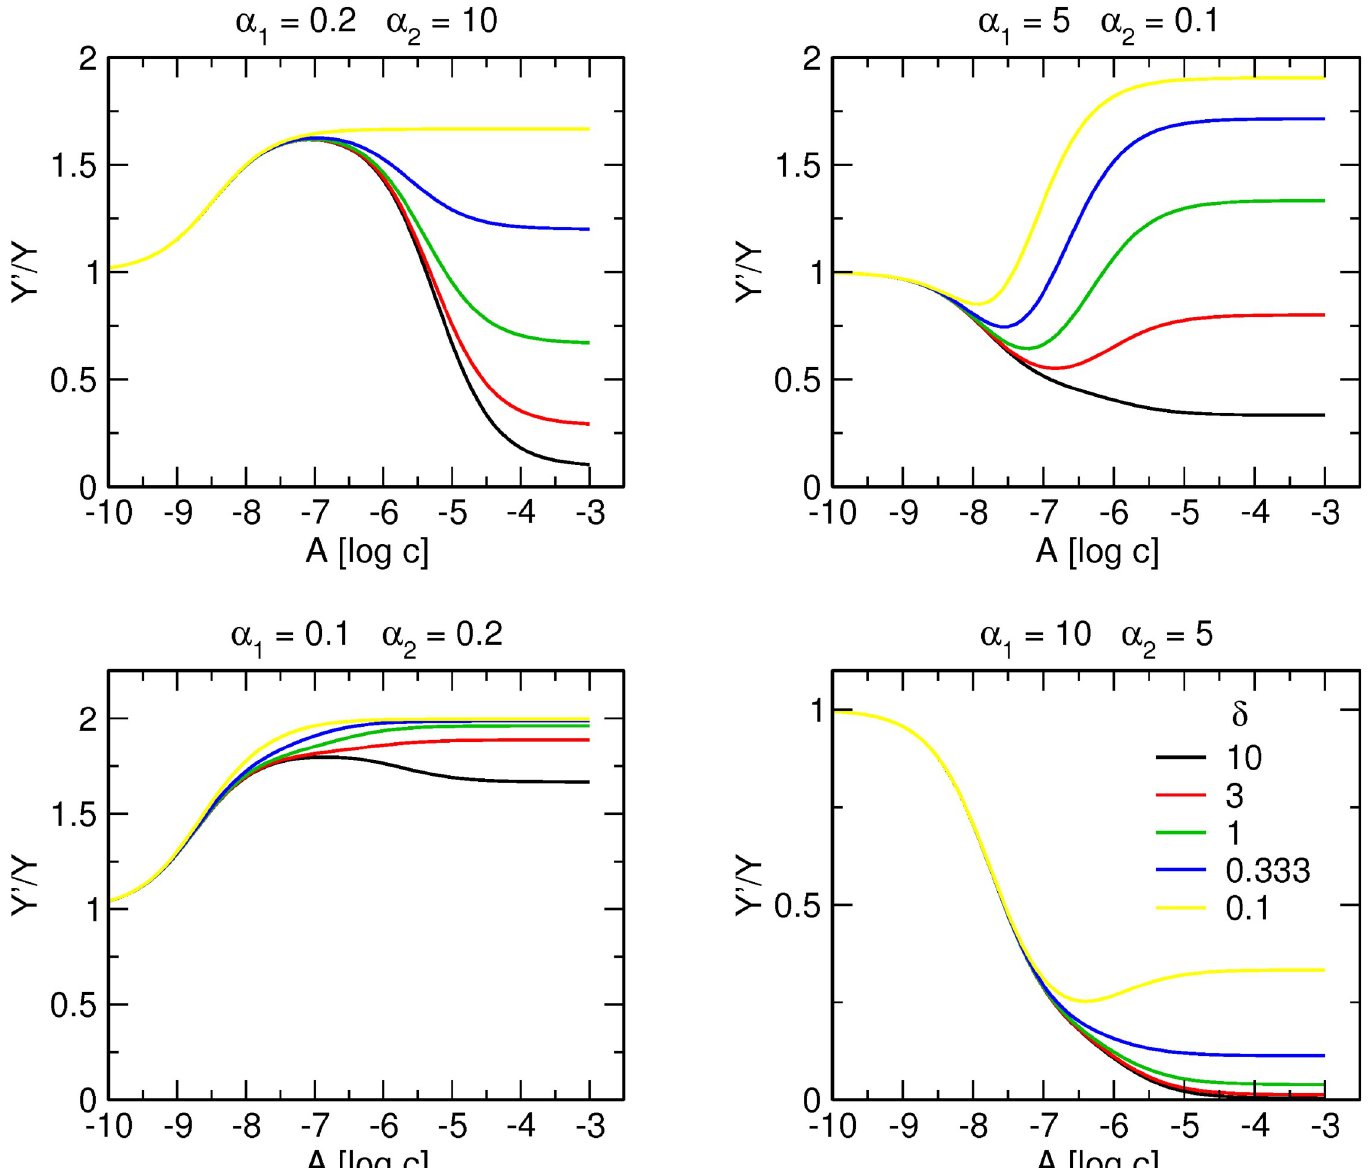
Fig 11. Effect of δ value on binding of allosteric modulator to two allosteric sites. Simulation of tracer binding (ordinate) in the presence an allosteric modulator binding to two allosteric sites for various combinations of positive and negative cooperativity with the tracer indicated at headings of individual plots. Binding of the tracer is expressed as fold over control binding in the absence of allosteric modulator. Abscissa, concentration of allosteric modulator expressed as logarithm of molar concentration. Value of cooperativity factor δ is shown in the graph legend. Simulation parameters: K X = 0.1 nM, [X] = 0.1 nM K A1 = 10 nM, K A2 = 1 μ M, γ = 1.